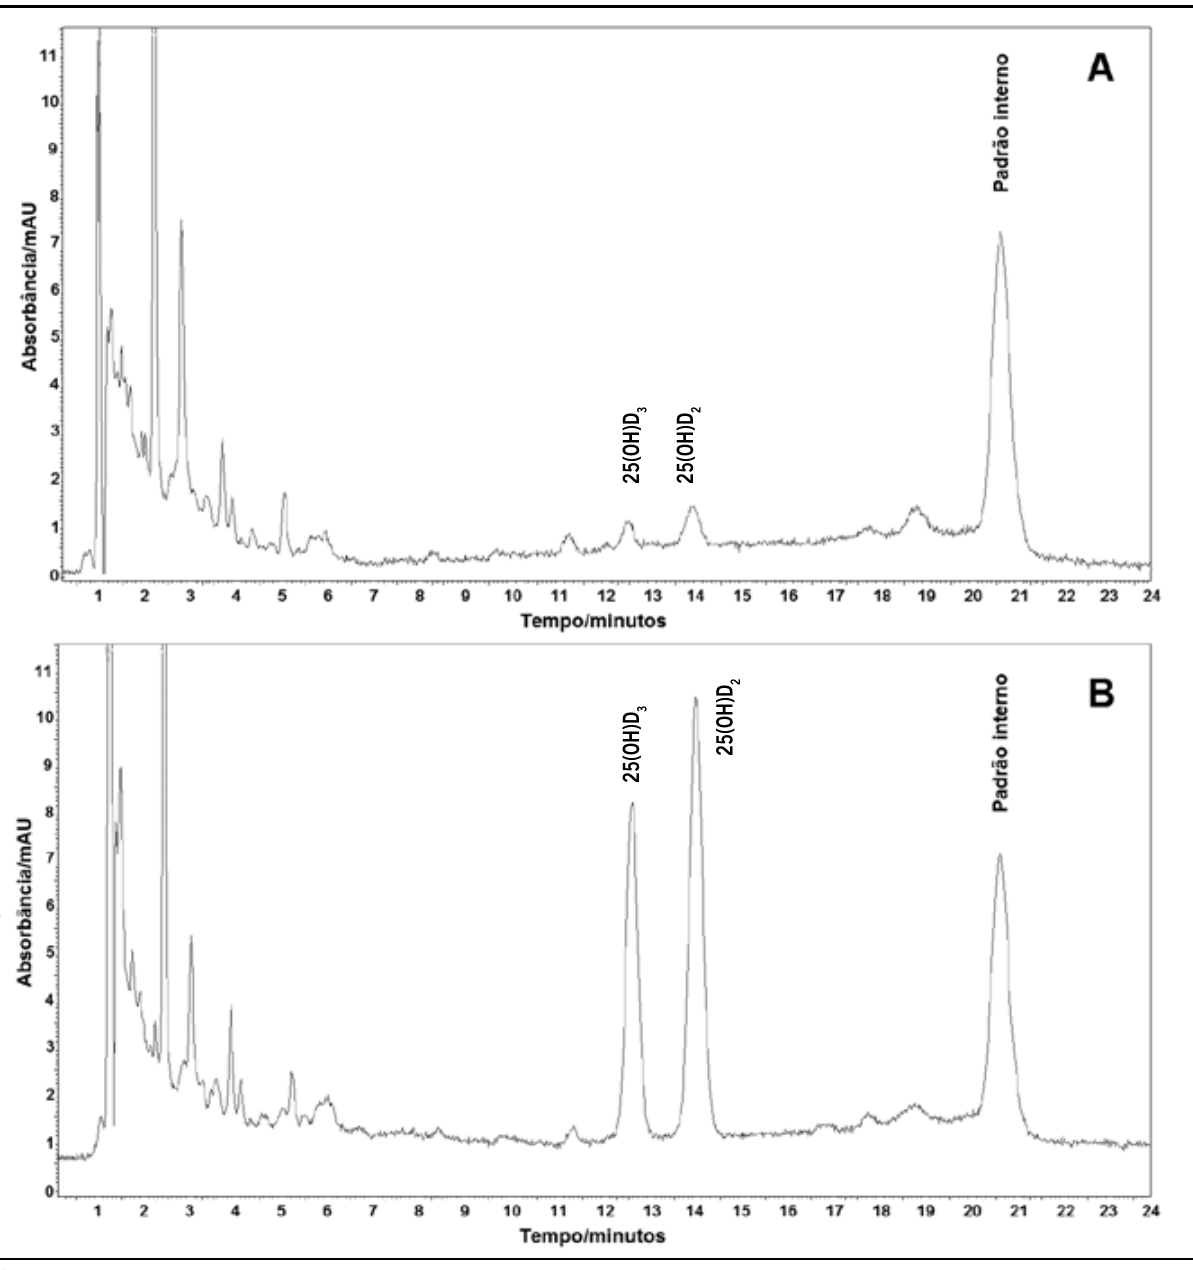
e 25(OH)D na concentração de 10 ng/ml; (B) amostra controle contendo 25(OH)D 3 2